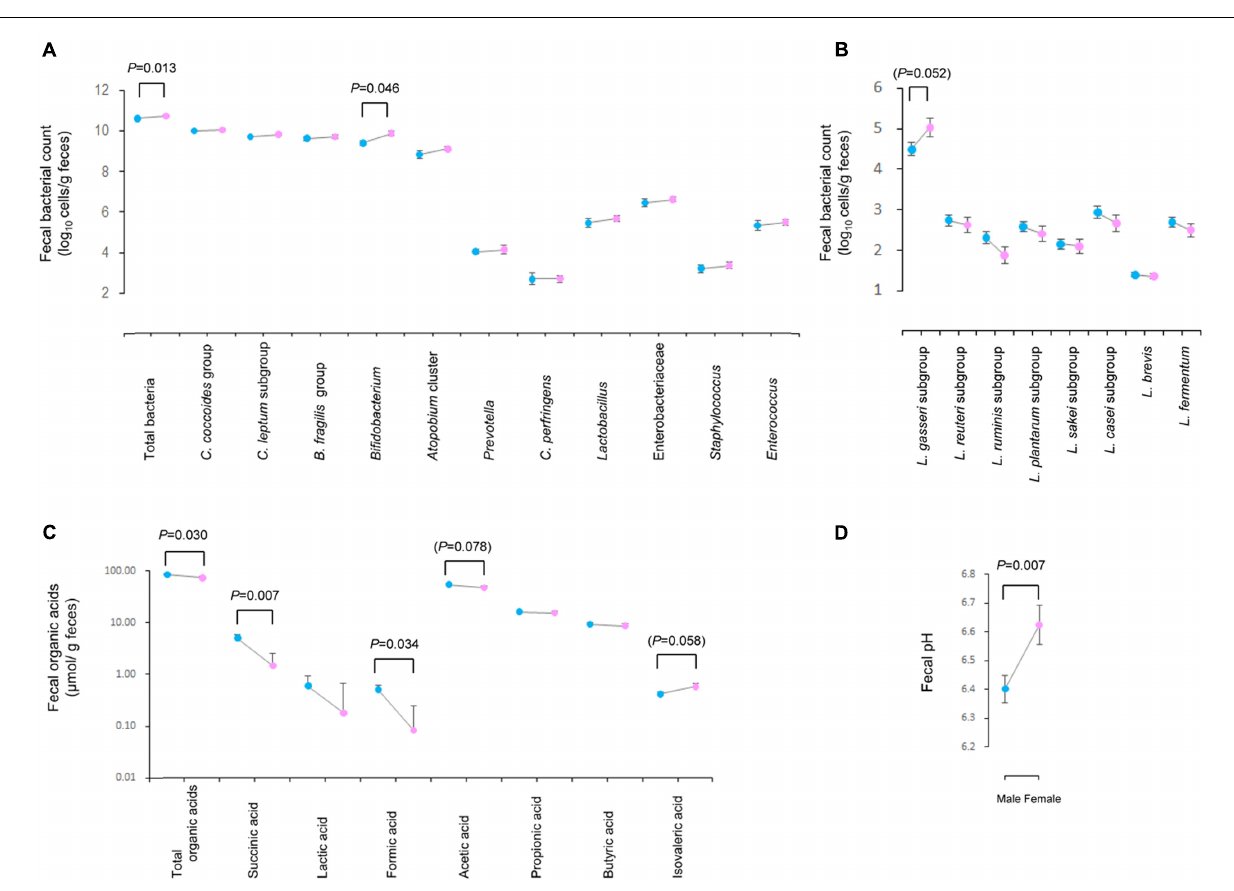
FIGURE 2 | Estimated marginal means calculated for fecal count of major intestinal bacterial groups (A) and Lactobacillus subgroups/species (B) , fecal concentration of organic acids (C) , and fecal pH (D) adjusted for the frequency of yogurt consumption. Dots and error bas represent the marginal estimated mean and standard errors, respectively. Blue and pink dots represent male (n = 212) and female (n = 81) data. P - value indicates the level of significance as tested by generalized linear model controlled for the frequency of yogurt consumption. In addition to P < 0.05, P < 0.1 is also presented in